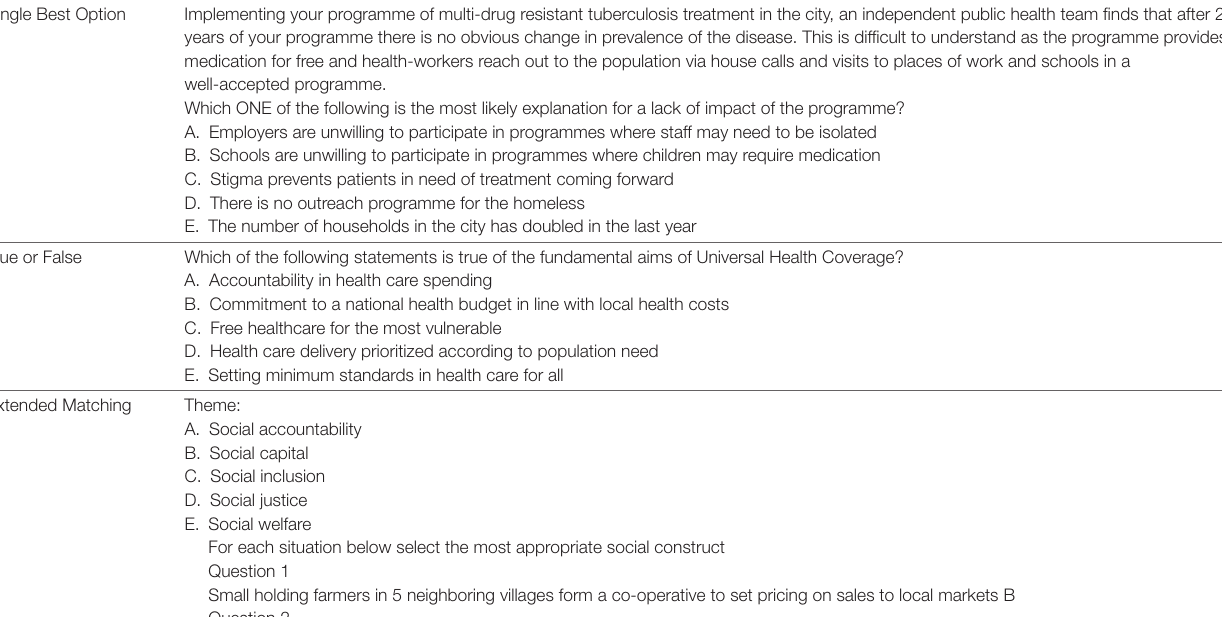
TABLE 7 | Global health examination questions in distinct MCQ formats. Single Best